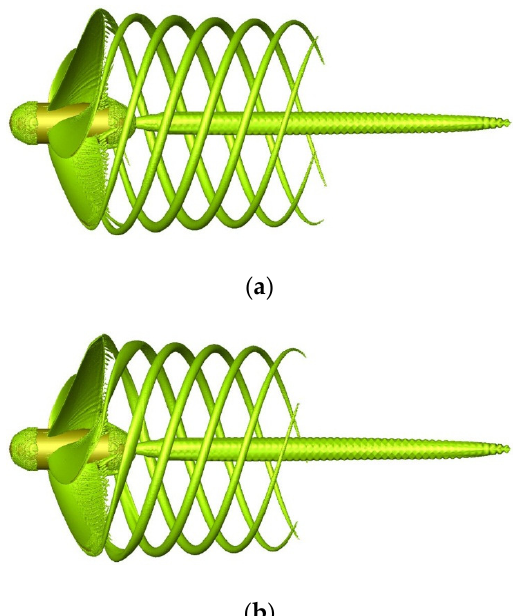
Figure 20. Iso-surface of Q = 2.0 × 10 4 1/s 2 at C Th = 1.08: ( a ) benchmark propeller and ( b ) winglet- propeller.